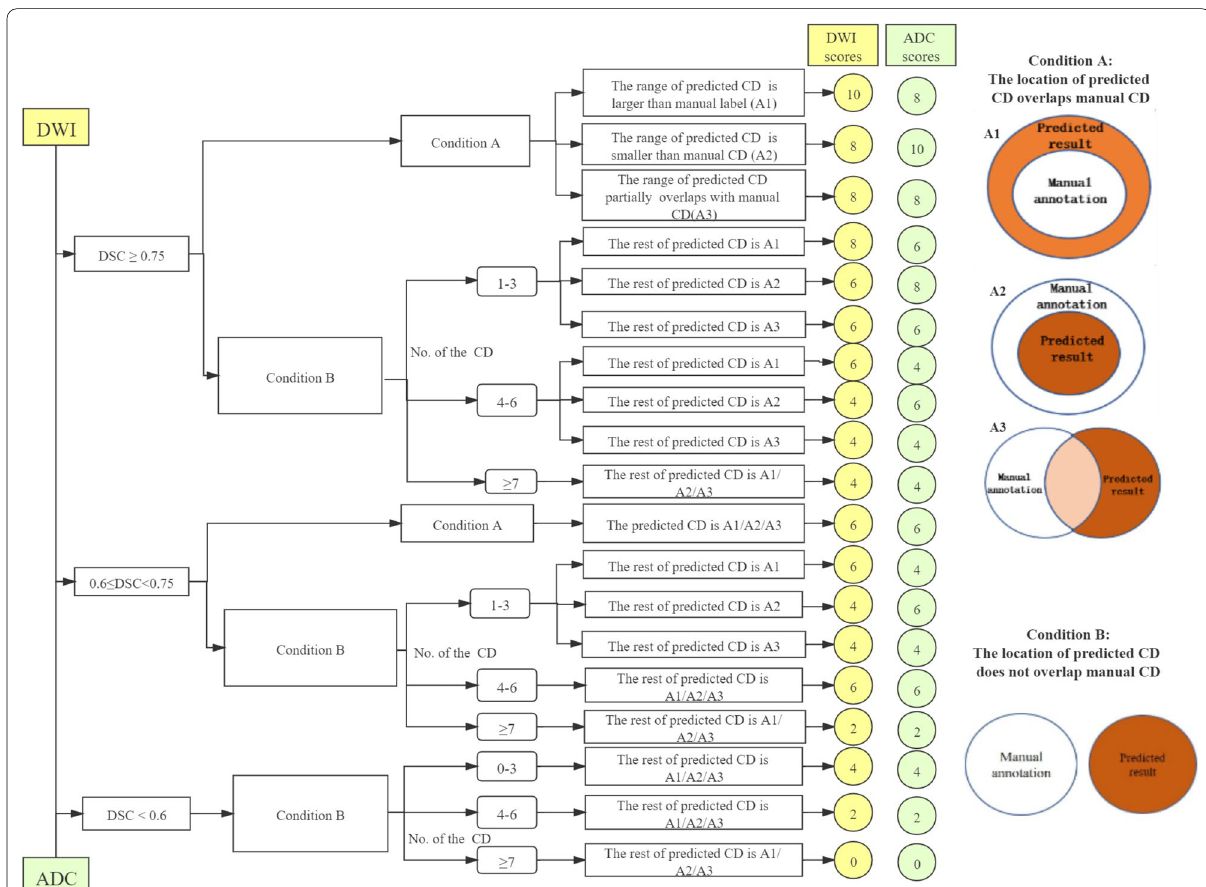
Fig. 3 The SCORE system and evaluation criteria on DWI images and ADC maps. According to the diagram of the SCORE system, the evaluation of the predicted segmentations on DWI images and ADC maps included three steps: firstly to calculate the DSC value of each label predicted by the model, then to judge whether the location of the predicted CD of the label overlaps the manually segmented CD, and finally to calculate the average scores of the labels according to the number of the predicted CDs that do not overlap with manual CD. Condition A means that the location of the predicted CD overlaps manual CD, and the range of the predicted CD is larger than (A1) or less than (A2) the manual CD, or partially overlaps with the manual CD (A3). CD connected domain, DSC dice similarity